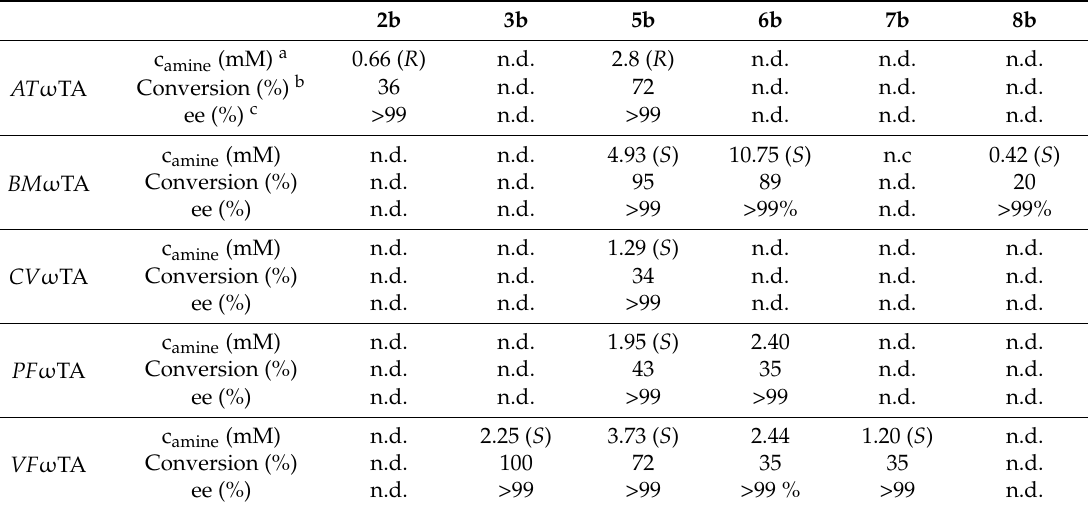
Table 2. Reductive amination of ketones.